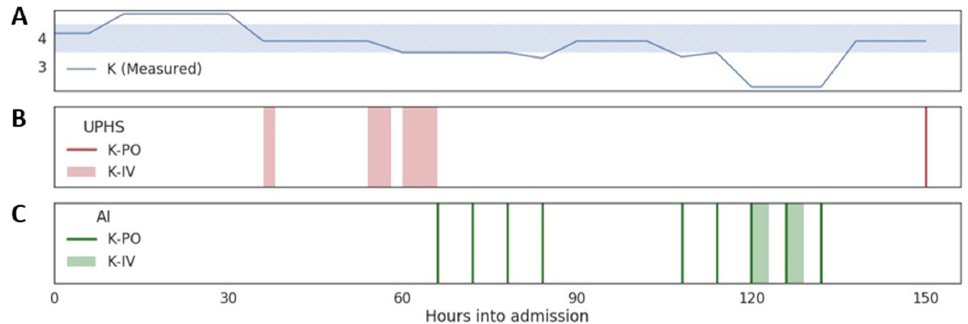
Figure 4. Panel ( A ) captures measured potassium ( y -axis) across hours into patient admission ( x -axis) with the gray ribbon visualizing the optimal range of potassium. Panel ( B ) is potassium repletion as performed by provider in historical data across hours into patient admission. Panel ( C ) is the recommendation for repletion across hours into patient admission driven by the learned RL protocol. The length of the shaded K-IV events indicates duration of infusion time.